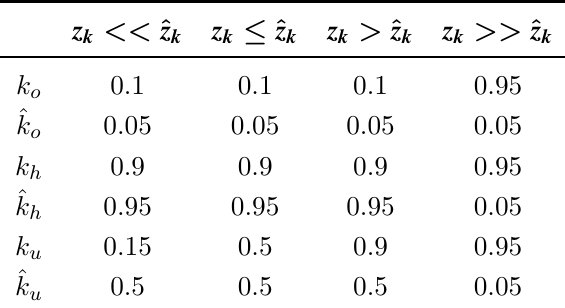
) and the estimated one ( ˆ z k k